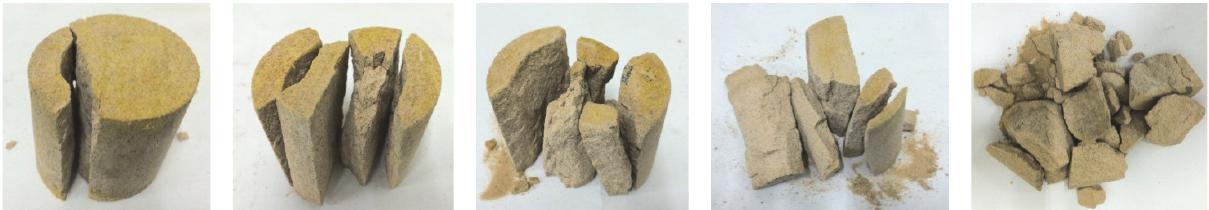
Figure 10: Failure forms under different freeze-thaw